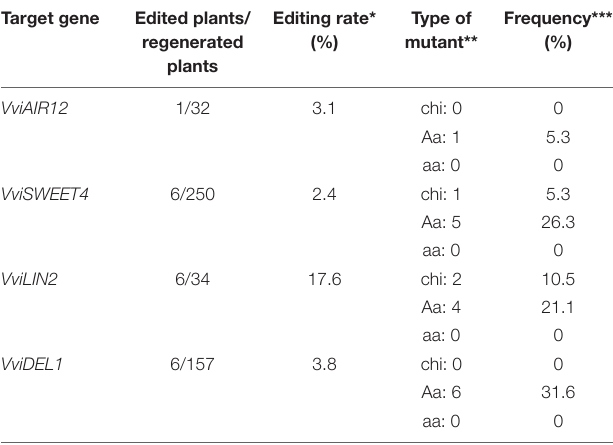
TABLE 2 | Grapevine whole plants derived from editing experiments using pGMV-based vectors. Target